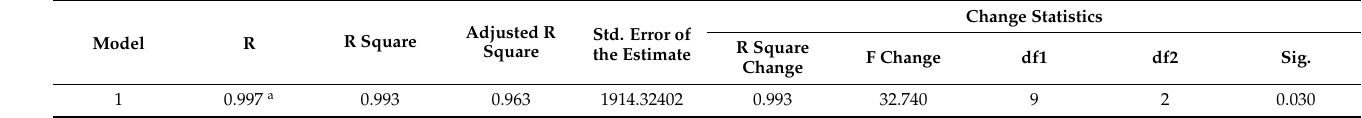
Table 7. SLR of TN4/5/21 and TN0: Model